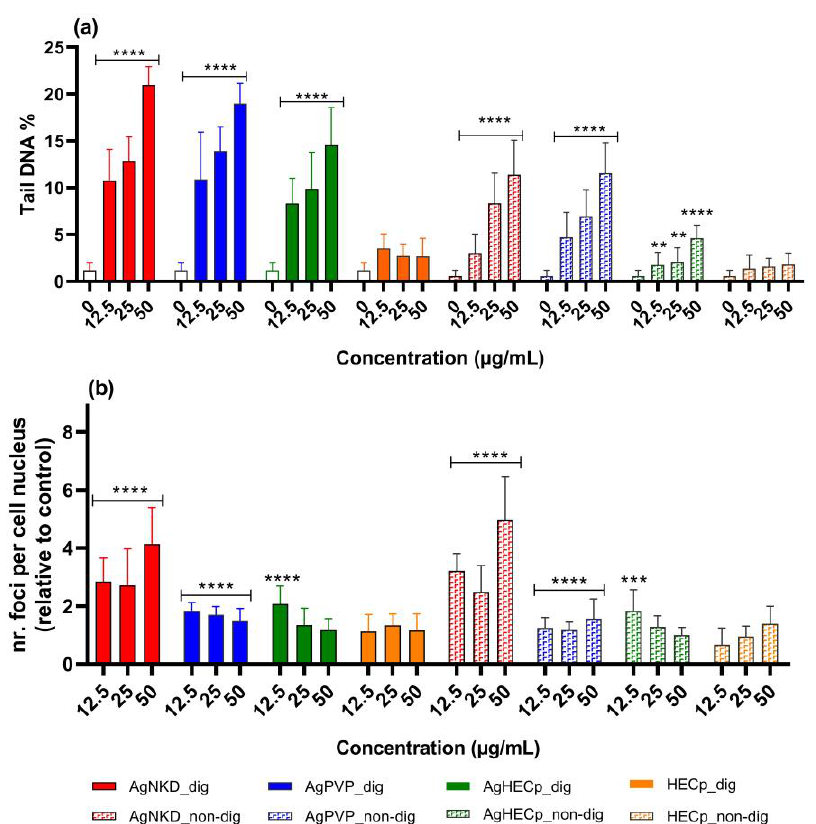
Figure 6. Genotoxicity of non-digested and digested Ag NMs and HEC. Genotoxicity was assessed using the comet assay ( a ) and 53BP1 assay ( b ), in HCT116 cells exposed for 24 h to 12.5, 25 or 50 µg/mL of non-digested or digested Ag NMs. Positive controls: 300 µM MMS (comet assay), 18.74 ± 3.62%Tail DNA, 50 µM etoposide (53BP1 assay), fold change 8.13 ± 1.03 relative to control. Statistical significance, exposed vs. control, (**) p <0.01, (***) p < 0.001, (****) p < 0.0001. After 24 h of exposure, whatever the Ag NP, a significant increase in the level of primary damage to DNA was observed in the comet assay. AgNKD caused the highest DNA damage, both in digested and non-digested forms. AgHECp induced less DNA damage than the other particles, and HECp did not cause any DNA damage. Statistically significant differences were observed between samples, for example at 50 µg/mL AgNKD and AgHECp ( p < 0.0001), AgPVP and AgHECp ( p < 0.001). The comet assay also revealed that digested samples induced more DNA damage than their non-digested counterparts, suggesting that the incubation of samples in OGI fluid played a role in their toxicity. We observed higher 53BP1 foci counts in cells exposed to AgNKD and AgPVP in comparison to the control. AgNKD was the most potent genotoxic agent in this assay. Significant differences were found between AgNKD and AgPVP (at 25 µg/mL p < 0.05, and at 50 µg/mL p < 0.0001), as well as AgNKD and AgHECp (at 25 µg/mL and 50 µg/mL p < 0.0001 for both). AgPVP and AgHECp induced a similar level of foci, and there were no significant differences between these samples at all tested concentrations. 3.6. Cell Cycle and Apoptosis DNA lesions are known to induce cell cycle blockade to ensure that cells have enough time to repair them. Moreover, the presence of a sub-G1 phase in the cell cycle is an indi- cation of apoptosis, which is a toxicity mechanism suggested in AOPs showing Ag NPs as stressors. Indeed, after DNA endonucleolytic cleavage, the fragmented low-molecular- weight DNA is released from cells during prolonged fixation. The accumulation of the